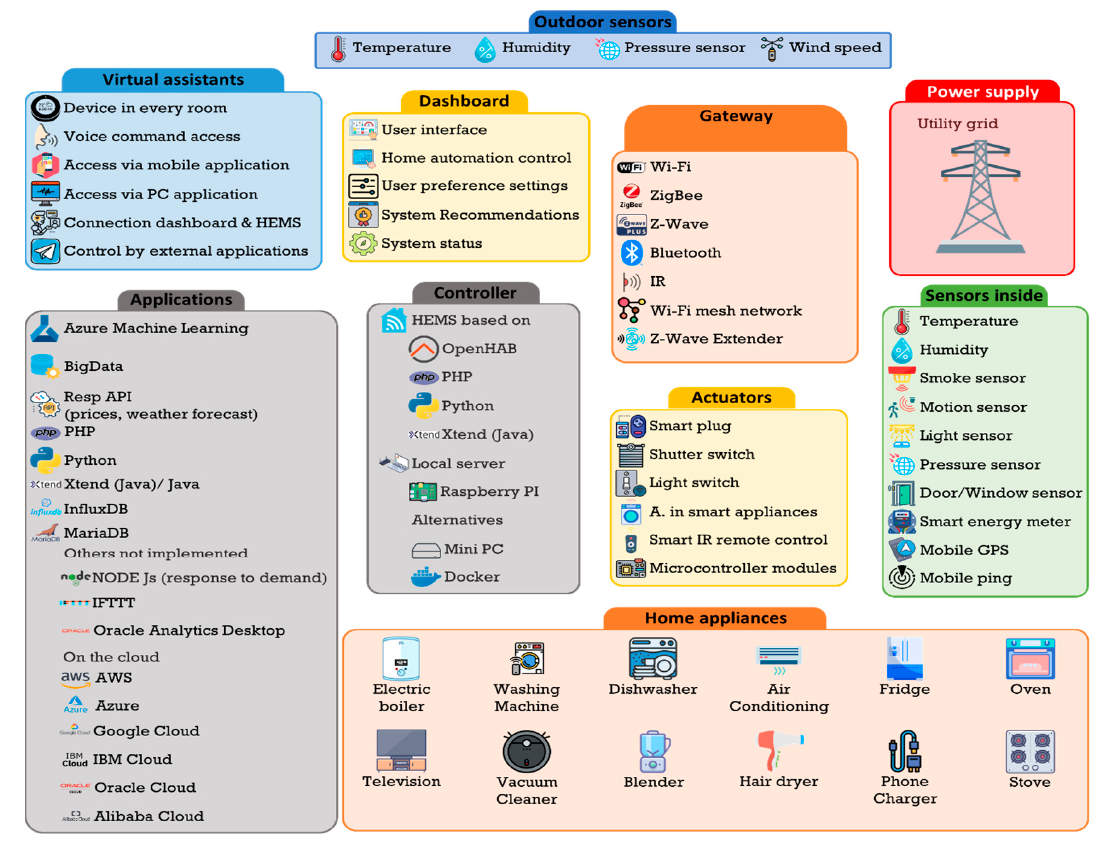
Figure 10. HERMES system infrastructure.